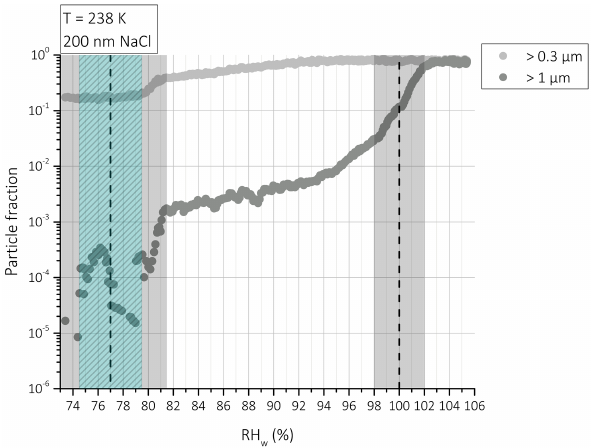
Figure 5. Particle fraction due to hygroscopic growth after deli- quescence as function of RH w at 238K for 200nm NaCl parti- cles. Vertical dashed lines represent deliquescence RH w of NaCl at RH w = 77% and onset of cloud droplet formation at RH w = 100%; green shaded area refers to observed uncertainty in deli- quescence by Koop et al. (2000b); grey area refers to the calculated variation and uncertainty of RH in HINC in the aerosol